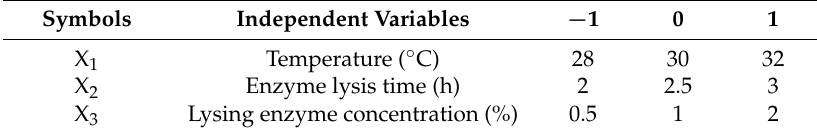
Table 5. Independent variables, symbols, and levels used in this Box–Behnken